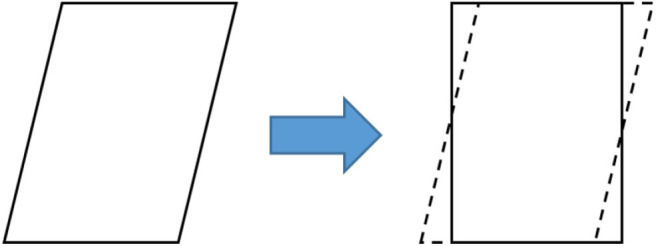
Parallelogram is transformed to rectangle. The whole area holds the same.